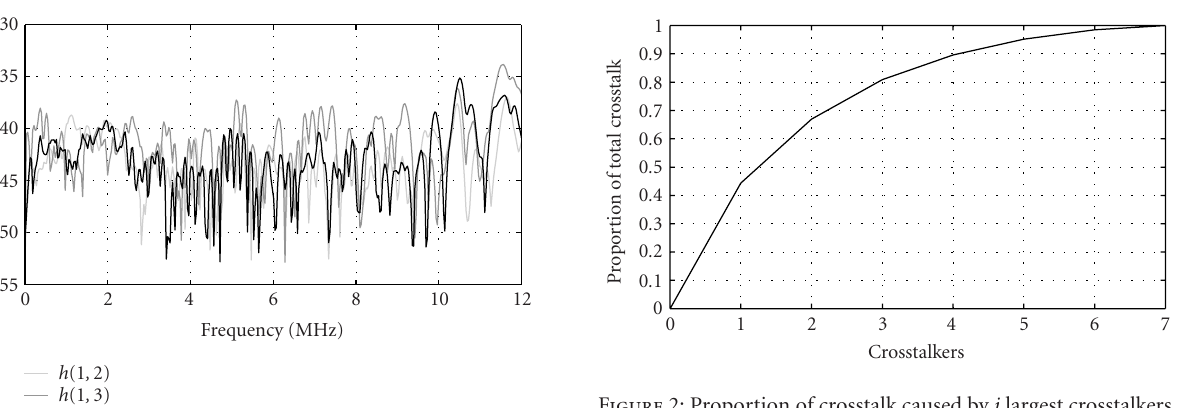
Figure 2: Proportion of crosstalk caused by i largest crosstalkers.